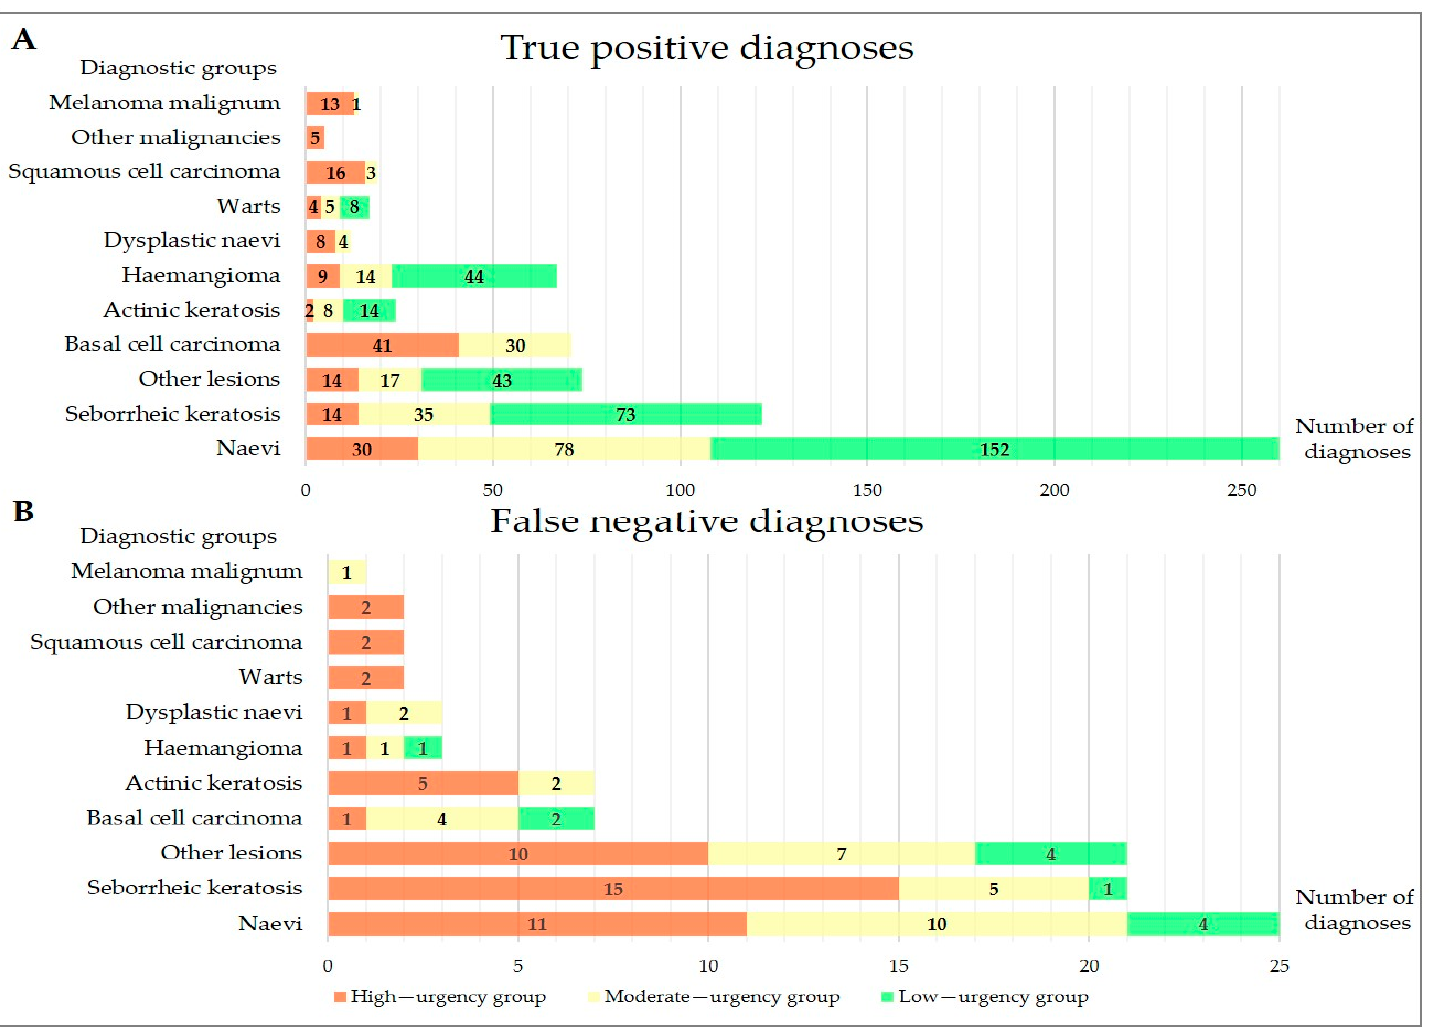
Figure 2. Distribution of different triage groups among true positive ( Panel A ) and false negative diagnoses ( Panel B ), considering aggregated diagnoses of the lesions during teledermatology consultations.